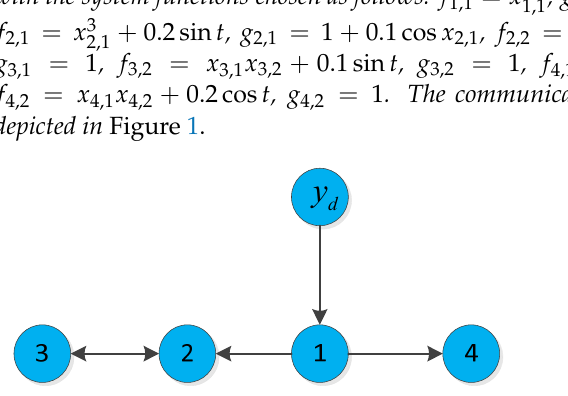
Figure 1. Communication topology for four subsystems.